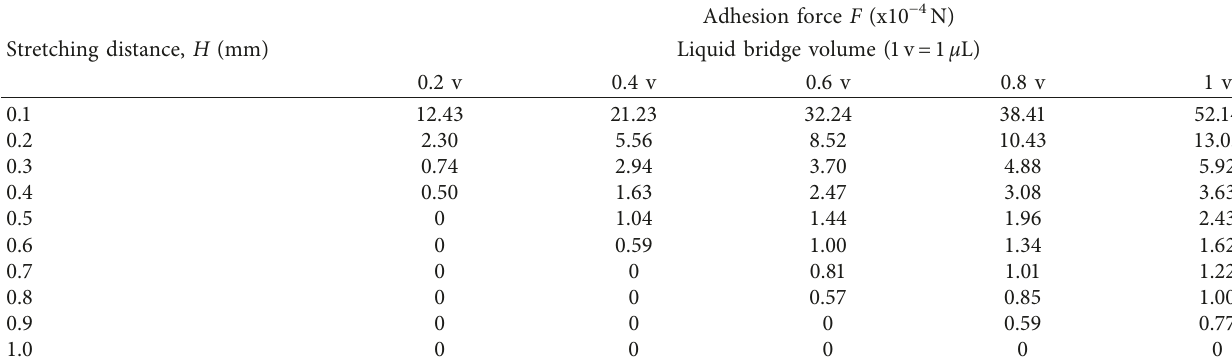
Table 6: Simulation values of liquid bridge adhesion under different liquid bridge